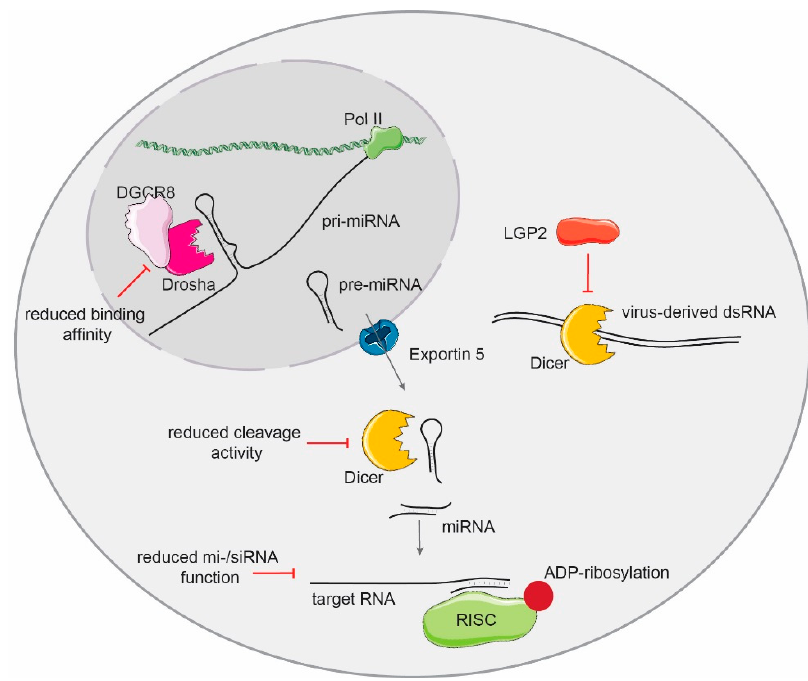
Figure 3. The activation of the type I IFN response impairs the activity and function of the small RNA biogenesis pathway. The microprocessor complex binding affinity and cleavage activity of pri-miRNA substrates is reduced upon IFN expression activation. IFNs also reduce Dicer protein levels and impair its cleavage activity. The function of the RISC complex is also modulated by the IFN response by poly-ADP-ribosylation of the essential component Ago2. The RLR LGP2 interferes with recognition and cleavage activity of Dicer on dsRNAs.